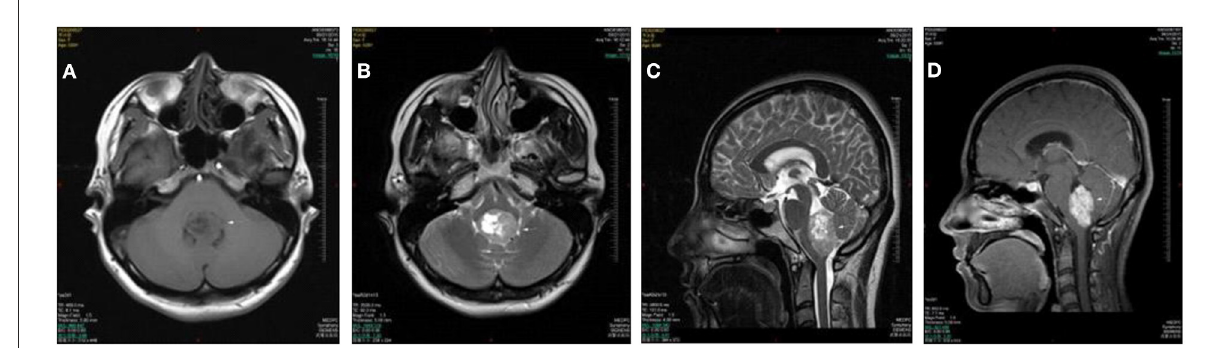
FIGURE1 Case 2: medulloblastoma of the fourth ventricle. Axial T1WI (A) and Axial T2WI (B) show a lobulated mass in the fourth ventricle with heterogeneously iso- to hypointense signal T1WI and iso- to hyperintense signal on T2WI. The lesion extrudes posteroinferiorly through the foramen of Magendie on sagittal T2WI (C) . The lesion shows a moderate heterogeneous enhancement on postcontrast axial T1WI with fat saturation (D)